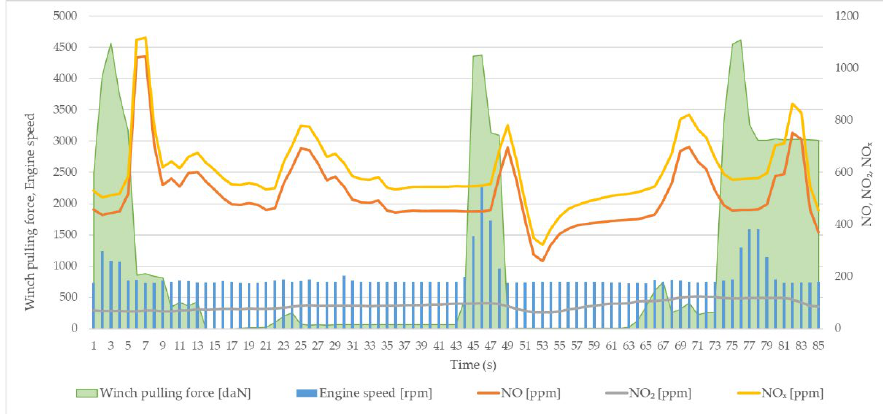
Figure 6. Change in the concentration of nitrogen compounds during engine load.